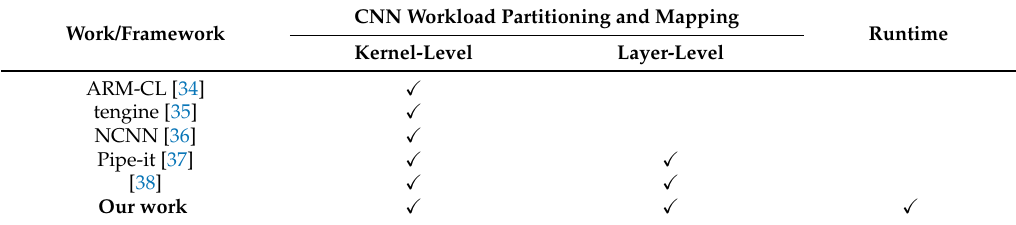
Table 1. Qualitative comparison with CNN workload partitioning and mapping studies.